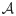
Repressilator regulatory system [5].The system consists of three genes connected in a feedback loop. The first gene in the circuit expresses some protein A which represses the second gene, the second gene expresses a protein B which represses the third gene, and protein C expressed by the third gene closes the feedback loop by repressing the first gene.